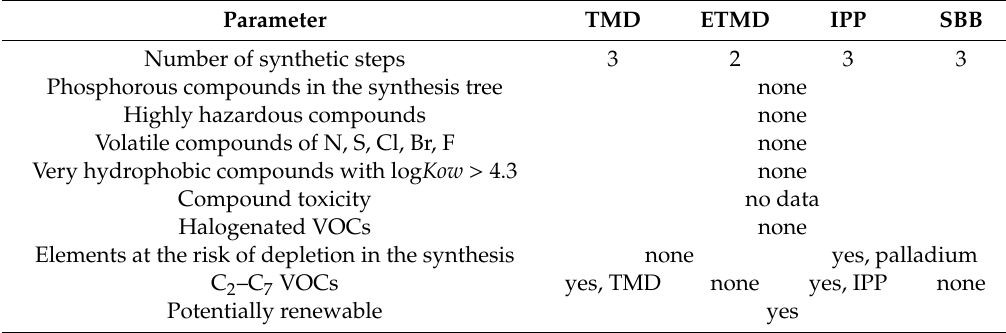
Table 14. The considerations of the renewable diols derivatives production sustainability. Parameter TMD ETMD IPP SBB Number of synthetic steps 3 2 3 3 Phosphorous compounds in the synthesis tree none Highly hazardous compounds none Volatile compounds of N, S, Cl, Br, F none Very hydrophobic compounds with log Kow > 4.3 none Compound toxicity no data Halogenated VOCs none Elements at the risk of depletion in the synthesis none Potentially renewable